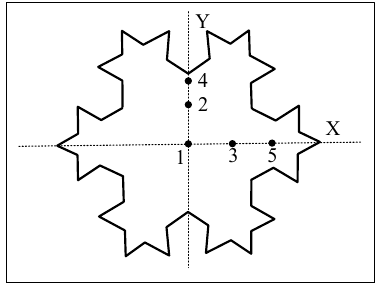
Figure 6. The antenna sensor.